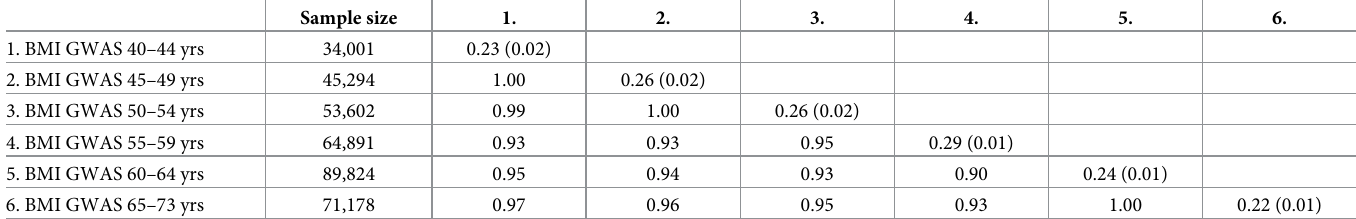
Table 1. Sample sizes, estimates of SNP-based heritability (including standard errors along diagonal) & linkage disequilibrium score regression genetic correlations between the six age intervals based on the combined male & female GWAS summary statistics.